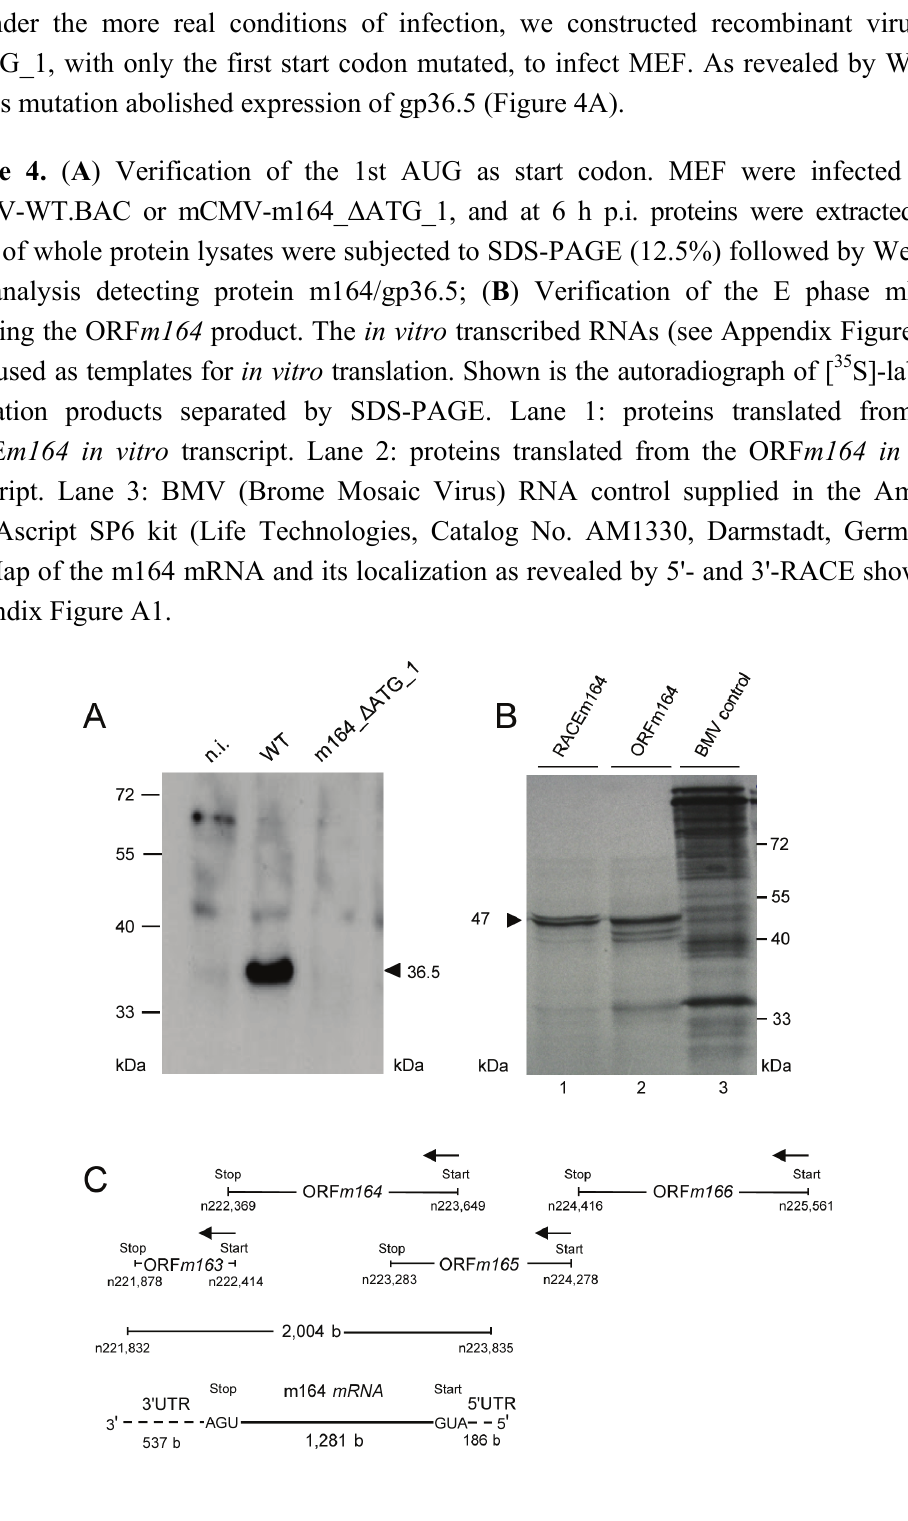
Figure 4. ( A ) Verification of the 1st AUG as start codon. MEF were infected